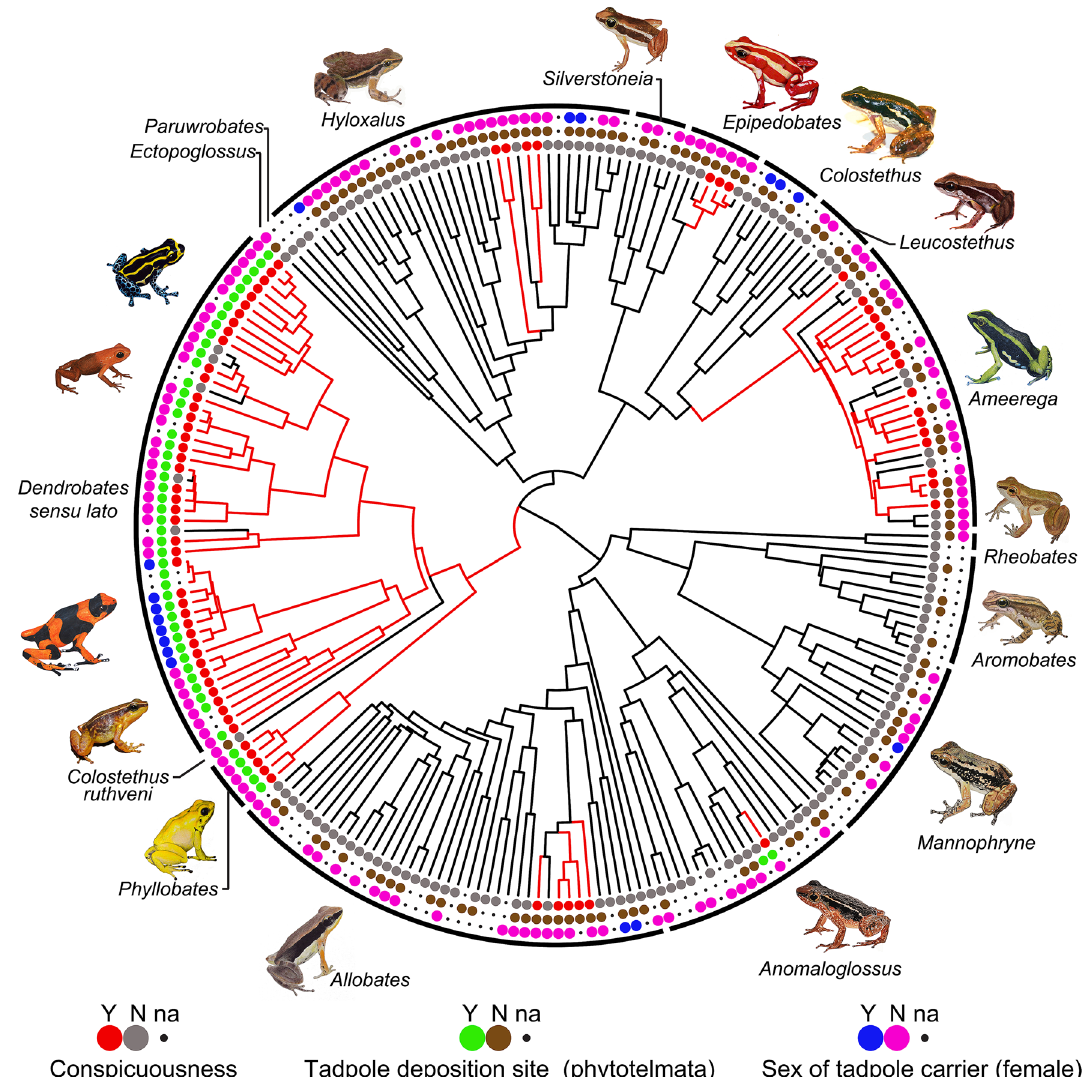
Figure 1. Ancestral reconstruction of coloration, tadpole deposition site and sex of tadpole carrier in Dendrobatidae. Illustrations by MJ Tovar-Gil, AM Ospina-L and DL Rivera-Robles. Figure was created using R software version 4.0.3 (https:// www.r- proje ct. org/) and modified using Adobe Illustrator version 15.1.0 (https:// www. adobe.